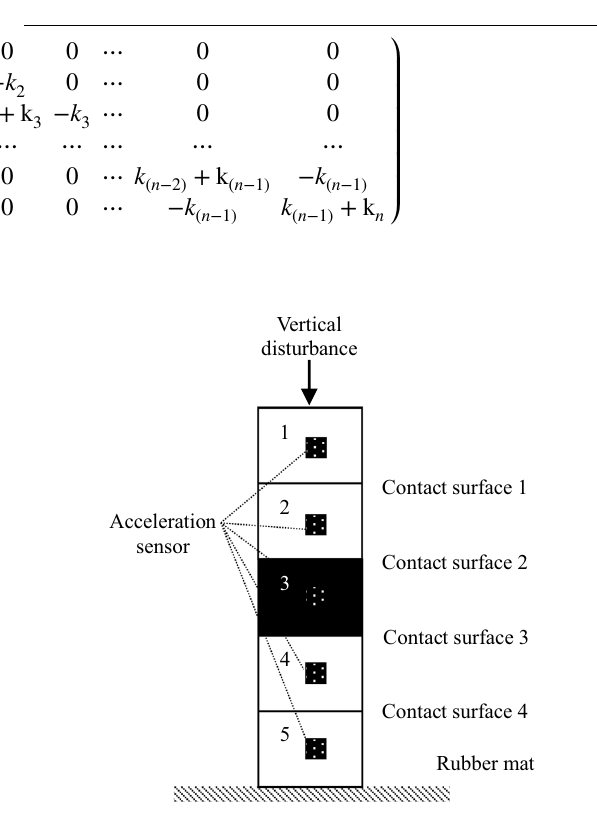
Fig. 2 Schematic diagram of verification test